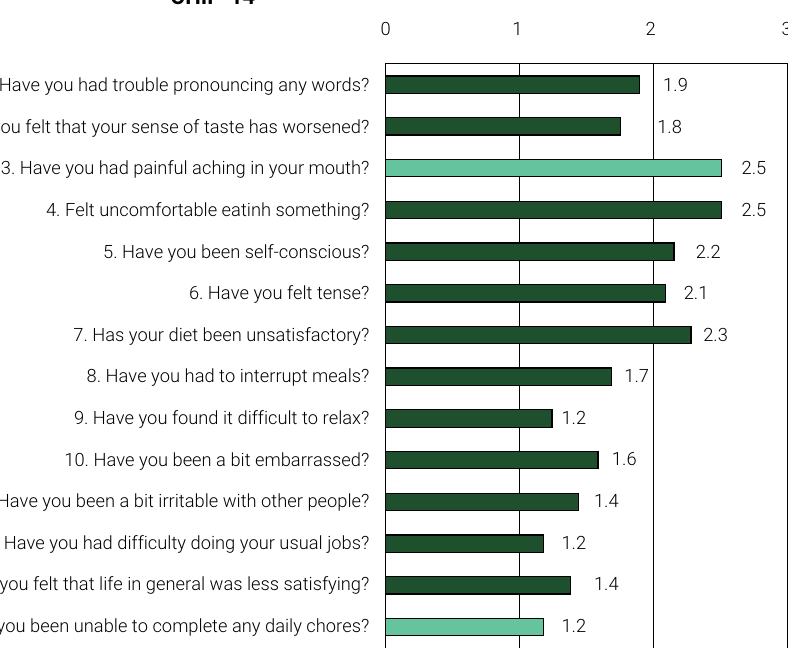
Figure 5. Mean agreement of each OHIP-14 question (total of 14 questions). The maximum score per question is 5. Higher scores indicate less OHRQoL (1 - Strongly Disagree / 5 - Strongly